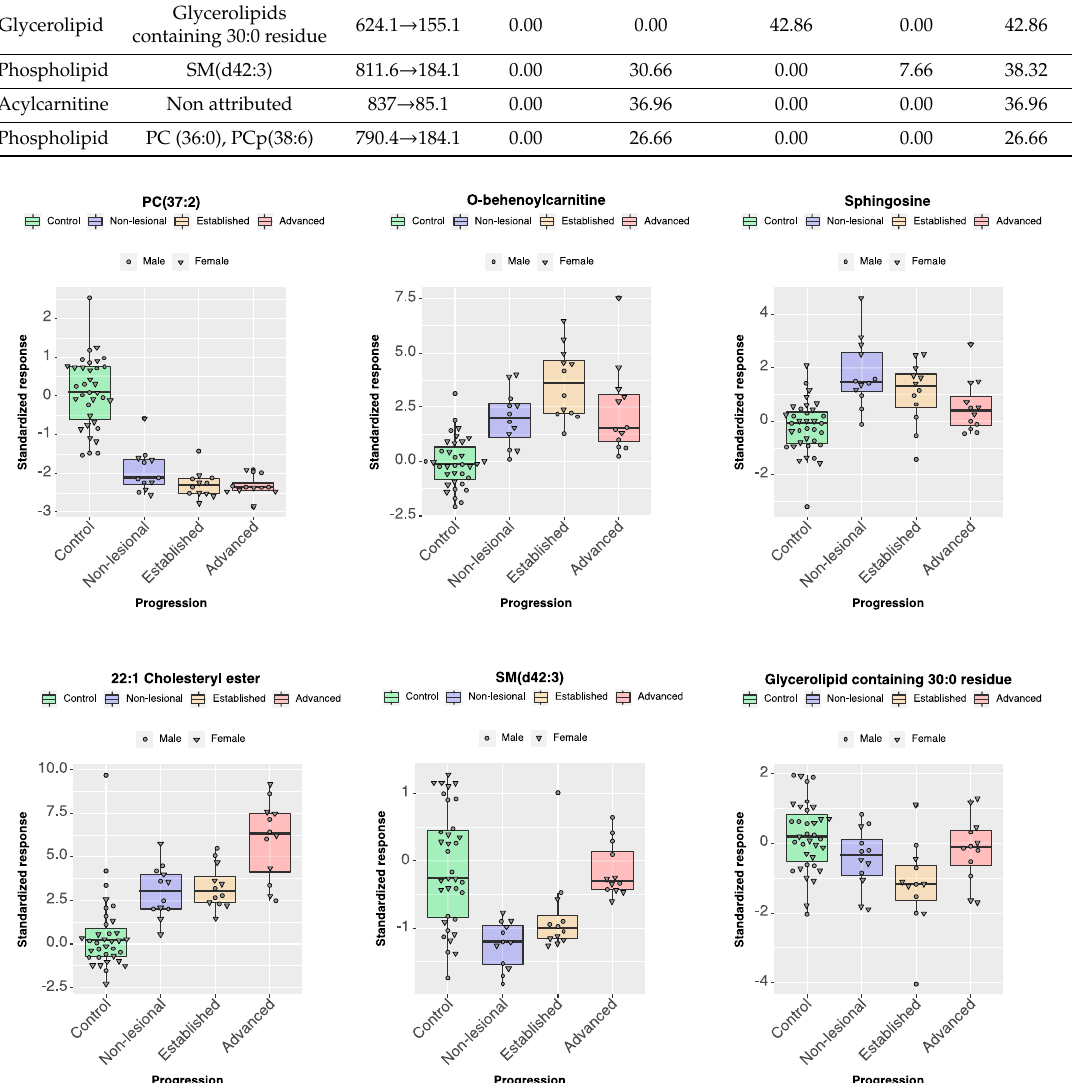
Figure 5. Epidermal lipid ions predictive of disease progression in mice. Representation of six lipids from the epidermis of WT and cpdm mice identified as predictive of disease stage in a sex-independent manner. Lipid features emphasize differences between controls and the various stages of the disease. The ENET classifier trained on the disease progression data was able to classify the 36 cpdm and 36 WT samples into groups, including the control and the three disease stages with an overall accuracy of 0.79, CI 95% = (0.67, 0.87) when classified using weighted classes and 0.95, CI 95% = (0.88, 1)